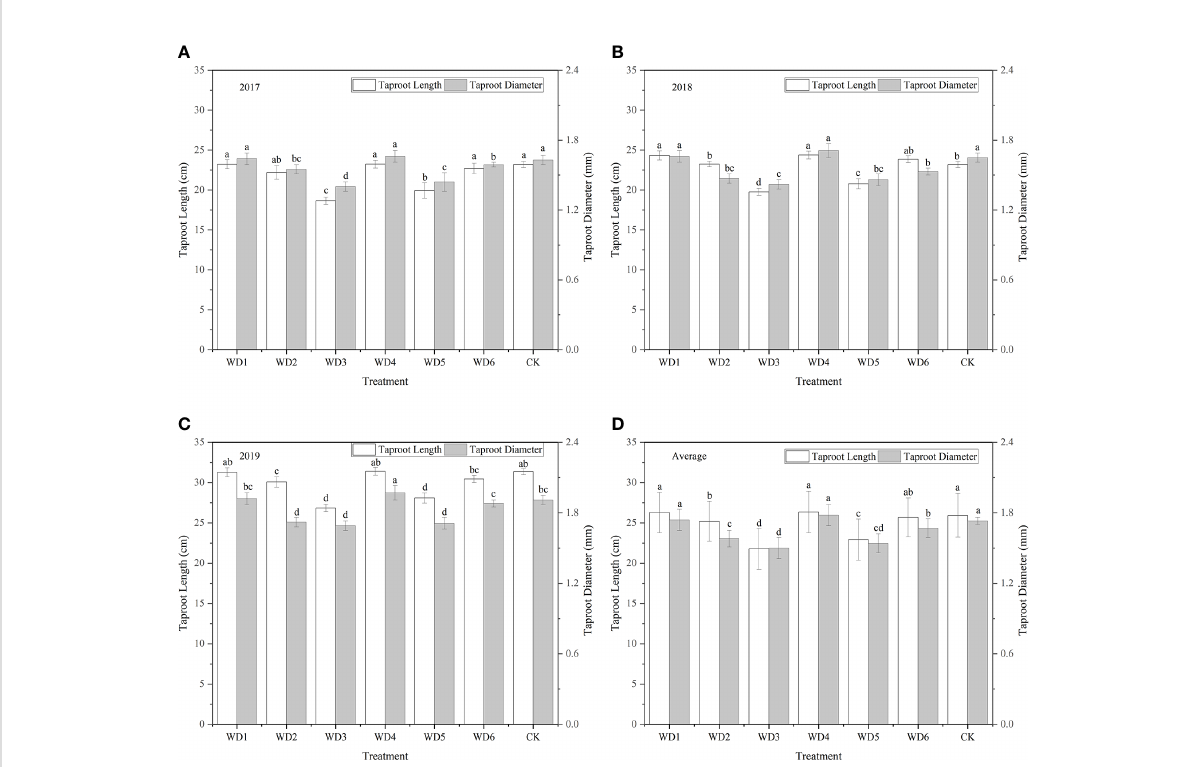
FIGURE 8 Taproot length and diameter of I. indigotica plants in different water de fi cit treatments. (A – D) describe the taproot length and diameter in 2017, 2018, 2019, and the average of these three years, respectively. Different lowercase letters in the same column indicate signi fi cant differences ( P < 0.05). Data were presented as mean ± SE (n =